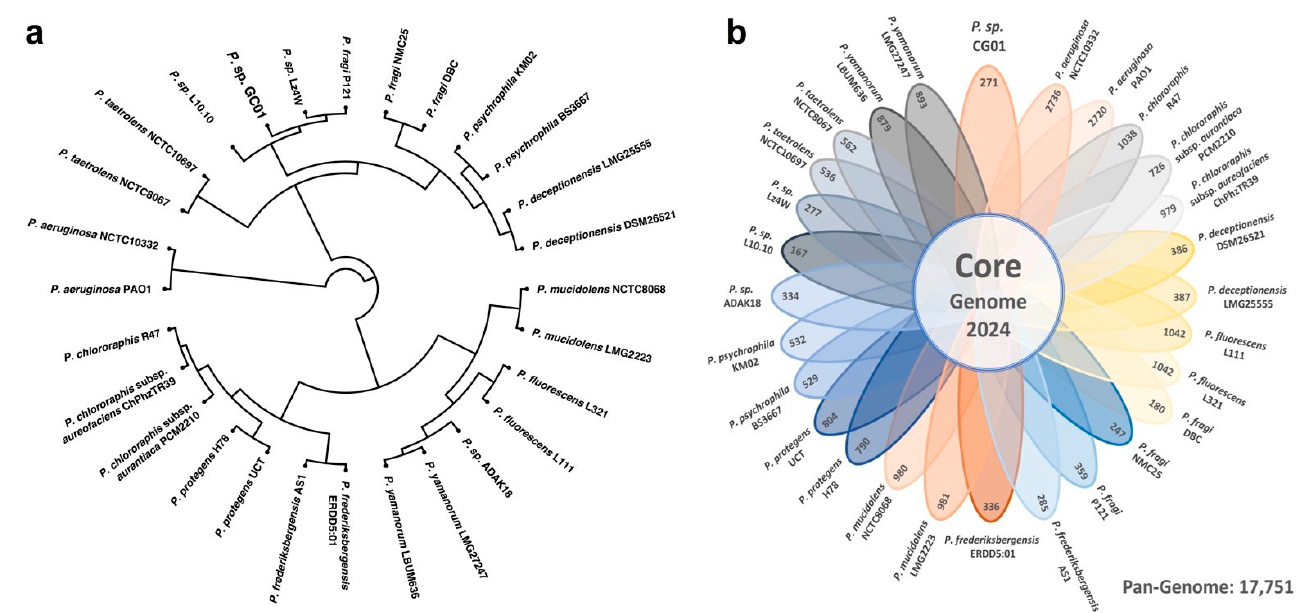
Figure 3. Phylogeny and pan-genome of 28 Pseudomonas strains. ( a ) Circular phylogenetic tree showing the relationships Figure 2. Heatmap displaying the relationships (hierarchical clustering) between the 28 Pseudomonas strains based on ANI between all Pseudomonas strains, inferred based on the core-genome sequences alignment. ( b ) Flower diagram representing analysis. The color gradients show the percentage of identity shared by each pair of genomes, from lowest (blue) to highest the amount of core and accessory clusters for each Pseudomonas strain considered in the (red).